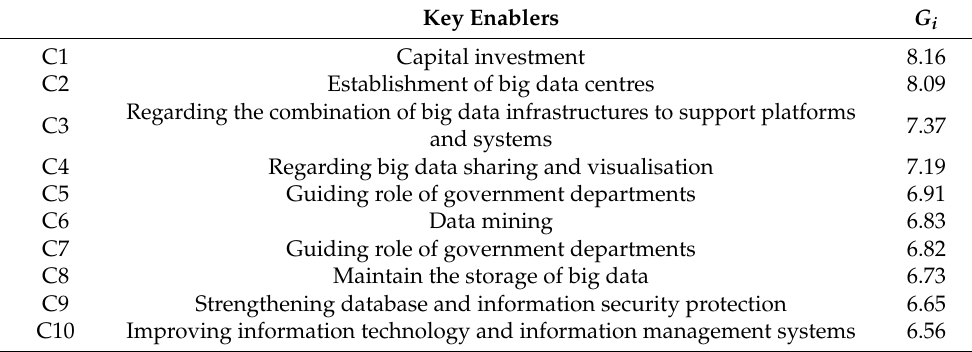
Table 13. Big data analysis